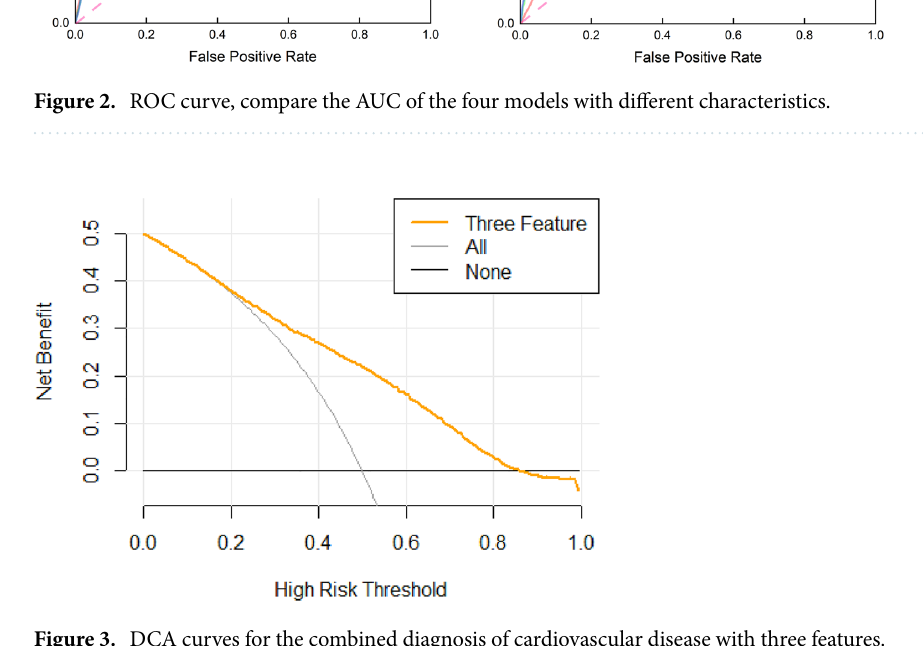
Figure 3. DCA curves for the combined diagnosis of cardiovascular disease with three